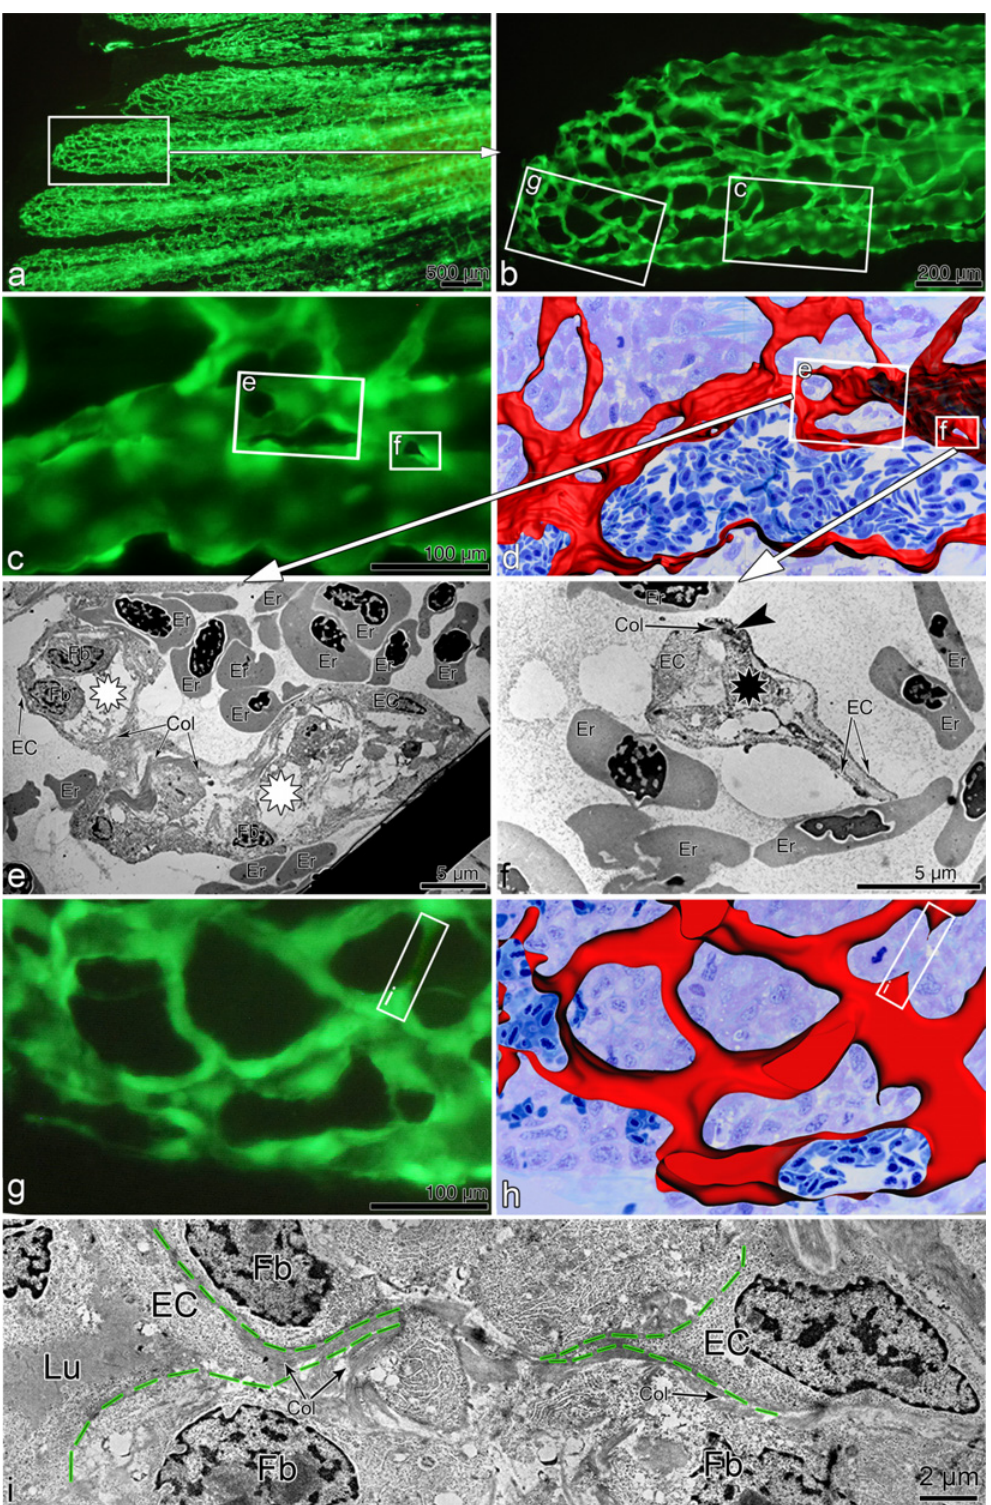
Fig 6. Correlative microscopy:Correlation of vascular alterations in vivo to their morphological substrate. in vivo. The in vivo fluorescent image in a shows the regenerating fin vasculature (5 dpa) at low magnification. b , c and g zoom in the site of interest indicated by rectangles. Based on serial semithin sections, panels d and h display the 3D-reconstruction of the areas depicted in c and g respectively. c-f : proximal region of interest, mainly characterized